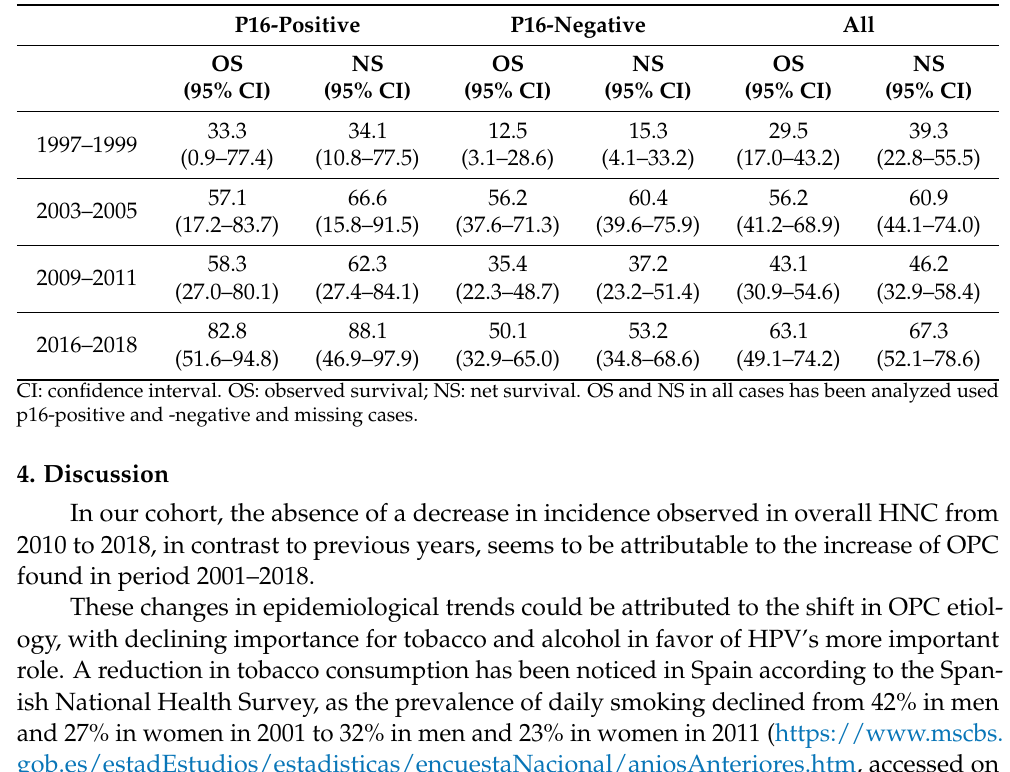
Figure 4. Observed survival according to p16 expression. Log rank test p < 0.001.